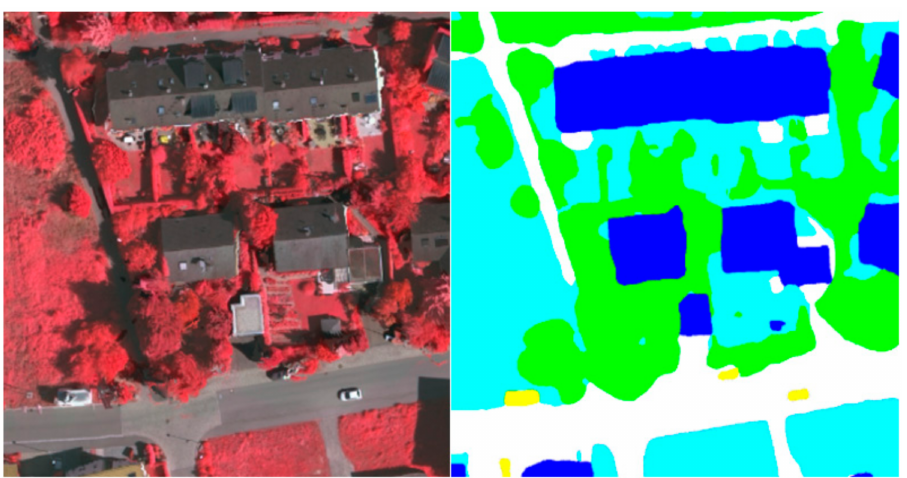
Figure 4. Visualization results of MFNet in the local area that belongs to the Vaihingen dataset.